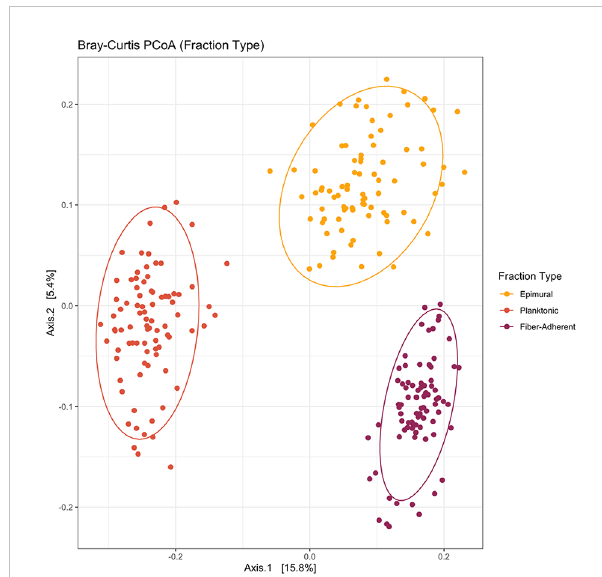
FIGURE 2 Bray-Curtis principal coordinates analysis among the three fraction types. Beta-diversity was measured using the Bray-Curtis distances and visualized with a principal coordinates analysis (PCoA). The epimural fraction is shown in orange, the planktonic digesta fraction is represented by red, and the fi ber-adherent digesta fraction is represented by purple. The circles represent a 95% con fi dence interval around the means of each fraction type. There was a signi fi cant amount of distance between each fraction type (P <